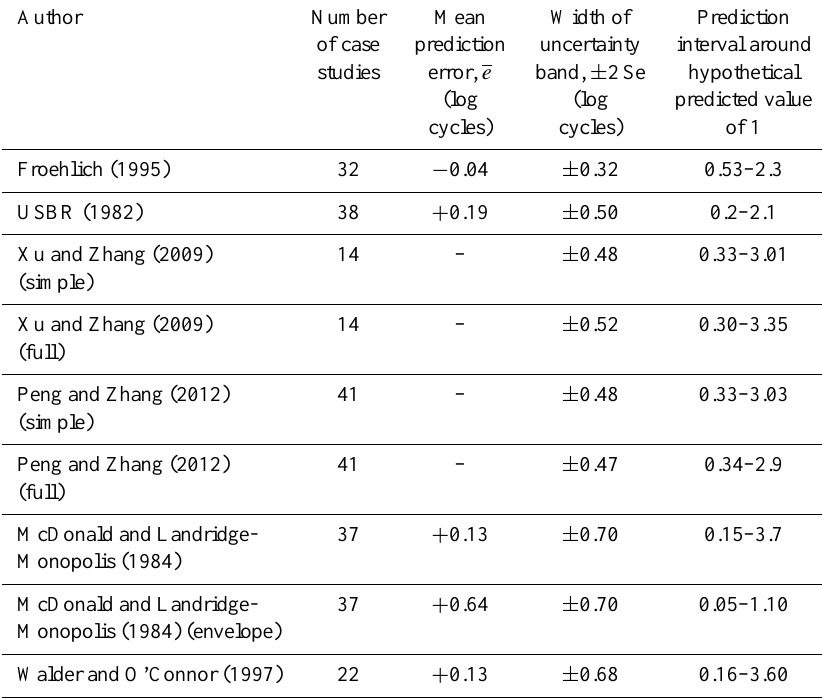
Table 2. Uncertainty estimates for peak flow predictions using empirical models (adapted from Wahl, 2004; Xu and Zhang, 2009; and Peng and Zhang, 2012).